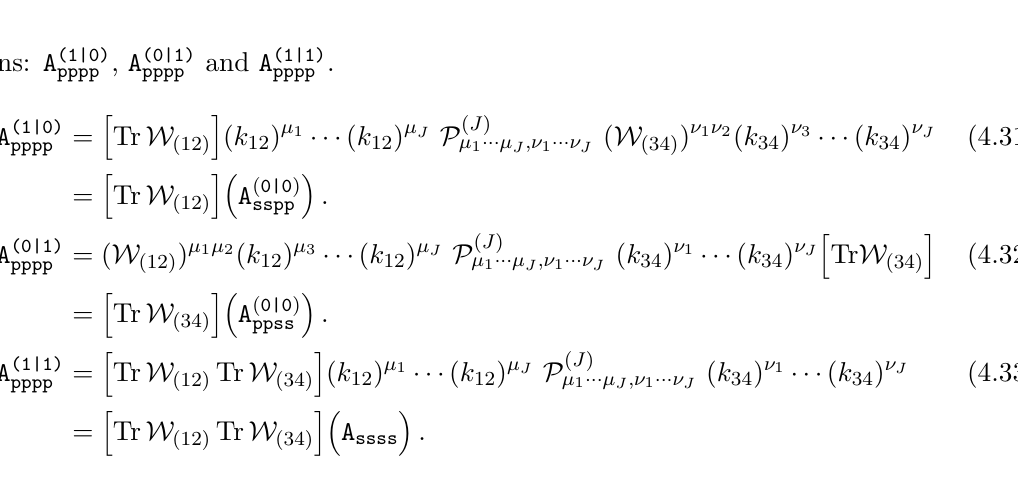
Table 3 . Angular distributions for the pppp tensor